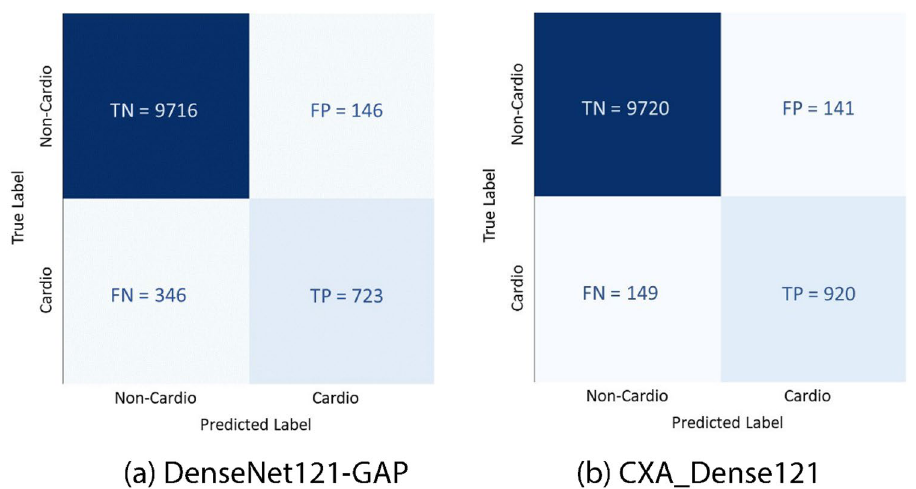
Figure 5. Comparison of confusion matrix of our ( a ) base model DenseNet121-GAP and ( b ) proposed best single model CXA_Dense121 under test